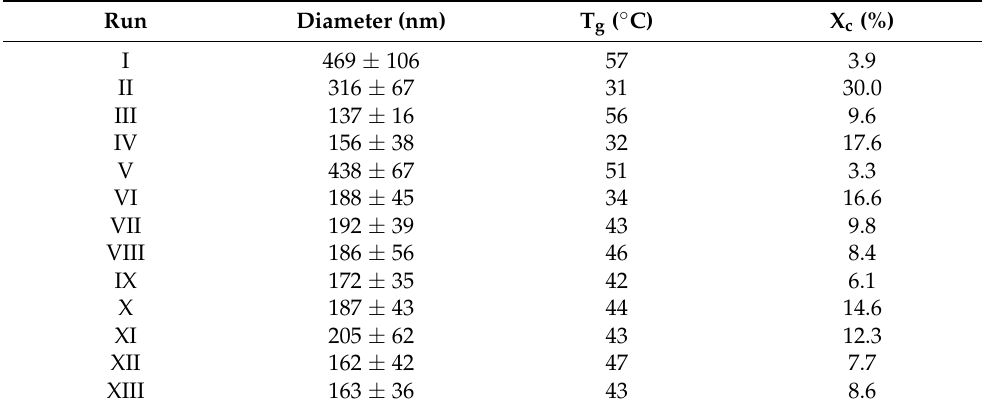
Table 2. Efibers experimental responses: Average diameter values, glass transition temperature, T g , and degree of crystallinity, X c .